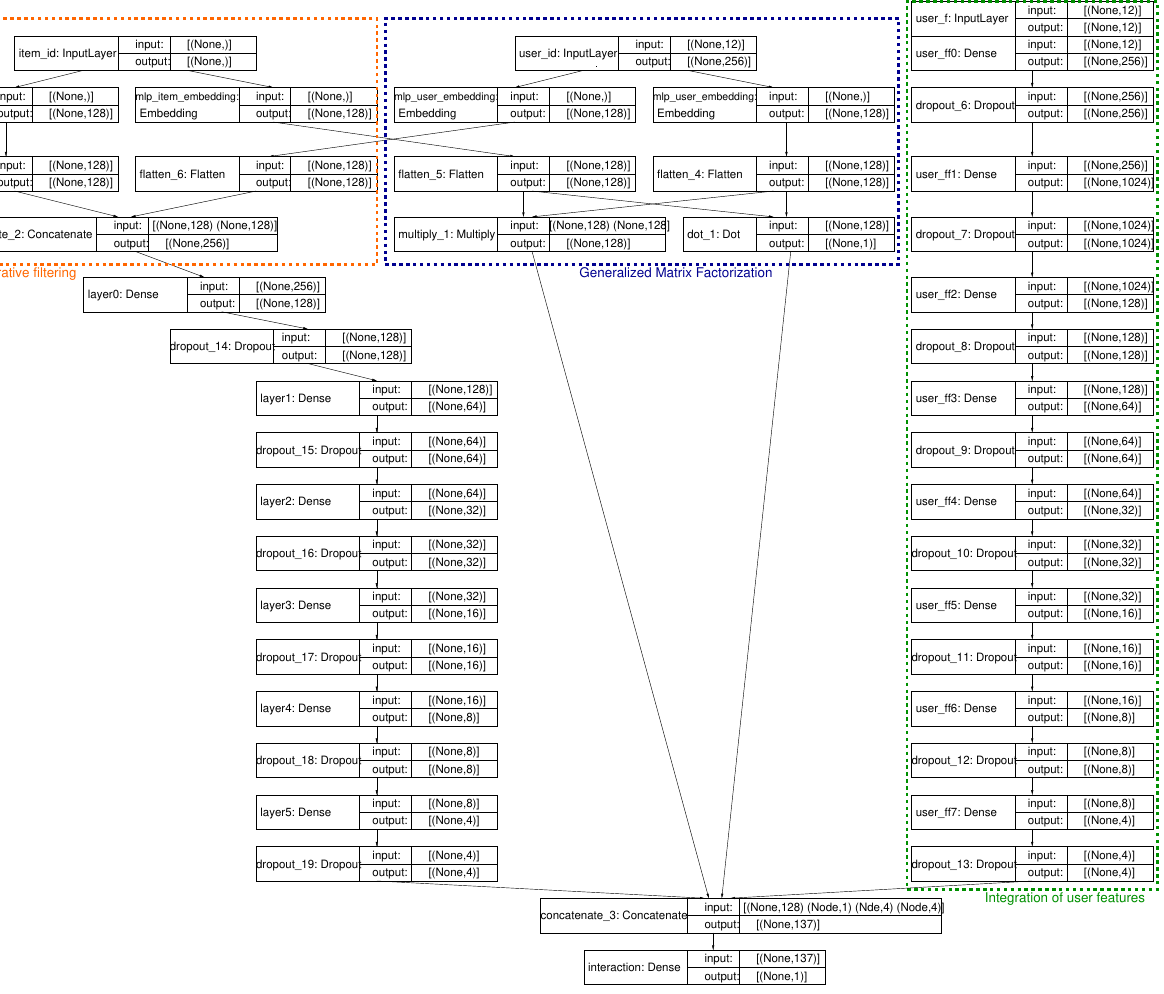
Figure 3. Full architecture and components of the proposed NMF hybrid classifier, part of Phase ϕ 4 . There are three parallel processing paths, neural collaborative filtering (orange), generalized matrix factorization (blue), and the ontology embedding deep network